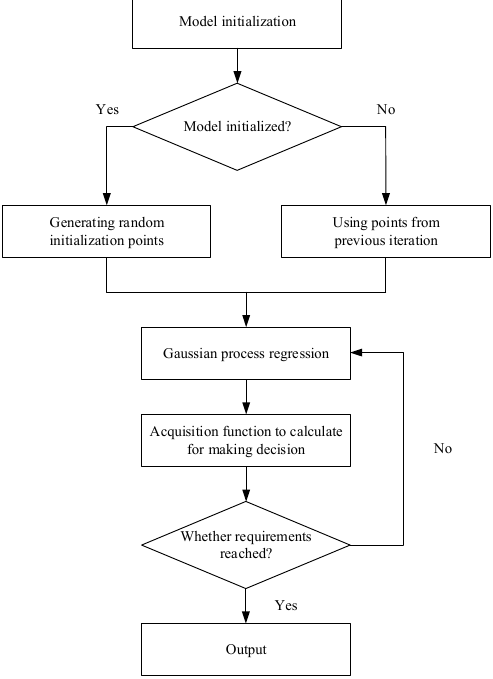
Figure 2. Flowchart of the Bayesian optimization algorithm.